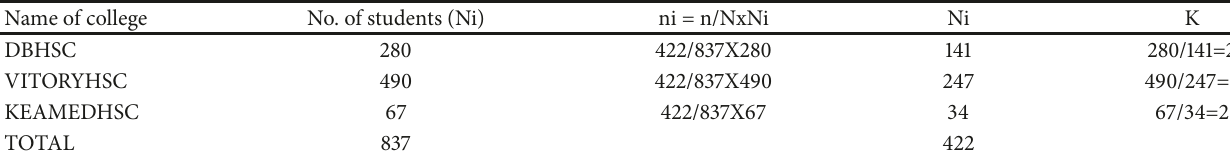
Table 1: Sample size distribution in each